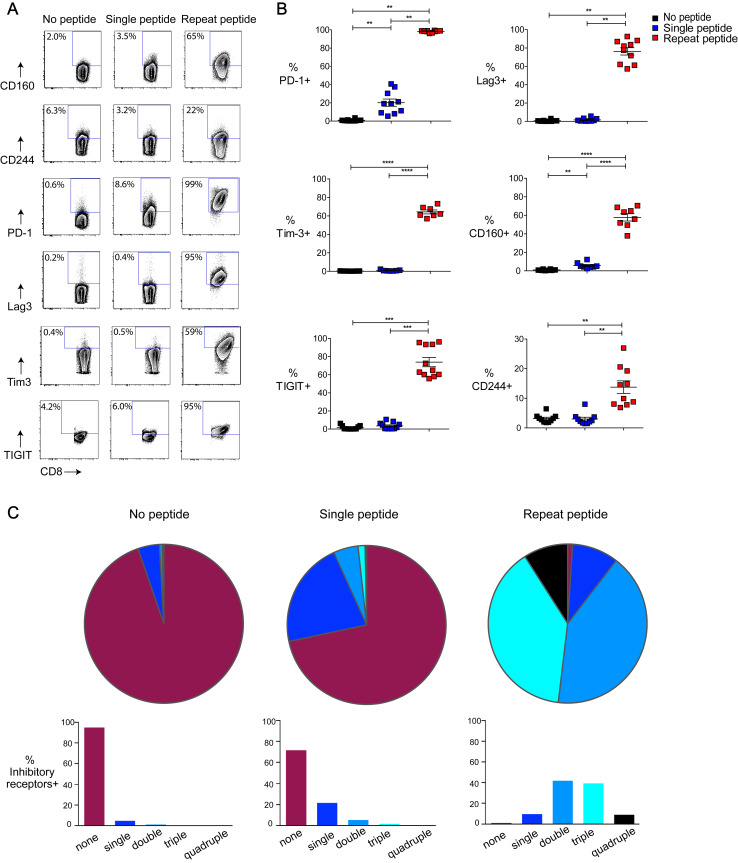
Repeat peptide stimulated cells express multiple inhibitory receptors.The expression of the inhibitor receptors PD-1, CD244, CD160, Lag3 were determined by flow cytometry on day 5 of in vitro culture of OT-I CD8+ T cells. Cells were cultured either without peptide (no peptide), one time OVA peptide stimulation (single) or daily peptide stimulations (repeat peptide). (A) Representative flow cytometry plots depicting the frequency of live CD8+ T cells expressing inhibitory receptors. (B) Pooled data of frequency of CTL expressing individual inhibitory receptors within the different culture conditions. (C) SPICE figures depicting the frequency of CD8+ T cells expressing one, two, three or four inhibitor receptors (PD-1, CD244, CD160, Lag3) simultaneously. Each symbol representative one animal (n = 7–11), with 7–9 independent experiments performed. Line depicts mean ± SE. Between the groups, Wilcoxon signed rank test was performed with exception of % Tim-3+ and % CD160+ for which a Student’s t test with Welch’s correction was used. *<0.05, **P<0.01, ***P<0.001, ****P<0.0001.